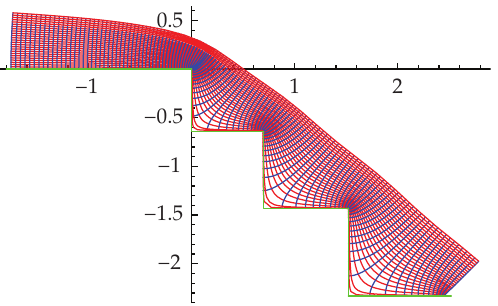
(cid:12) (cid:10) z (cid:5)Γ(cid:5) 1 / 2 − x (cid:6) / Γ(cid:5) − x (cid:6)(cid:6) 0